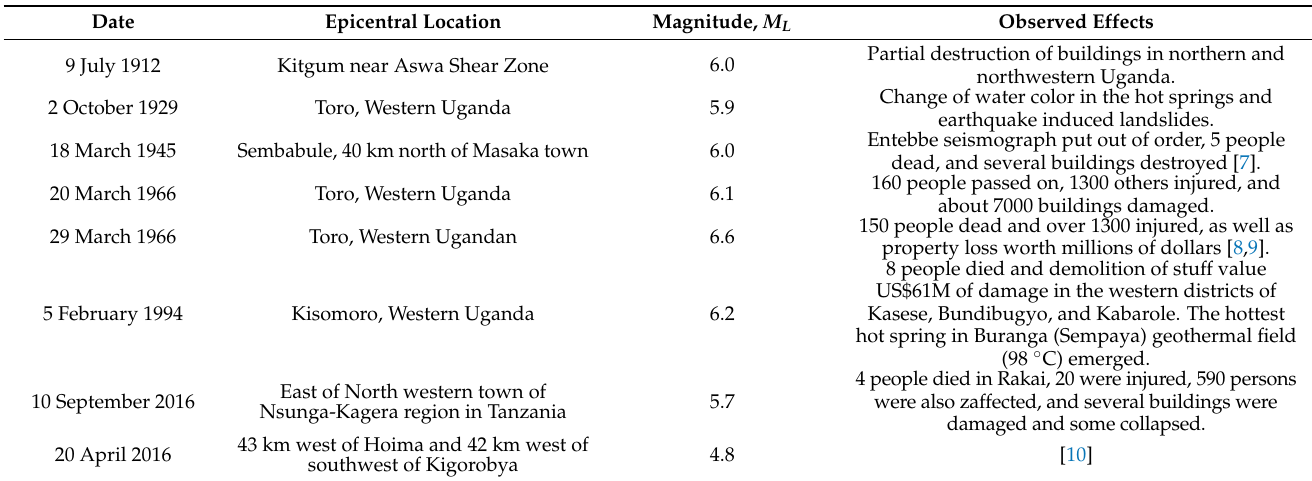
Table 1. Examples of major earthquakes in